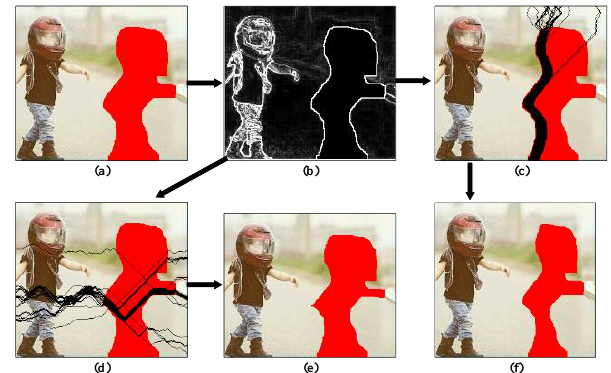
Figure 2. Seam carving steps. (a) Original image. (b) The energy of the original image. (c) Determine 20 vertical seams. (d) Determine 20 horizontal seams. e) Remove 20 horizontal seams. (f) Remove 20 vertical seams.